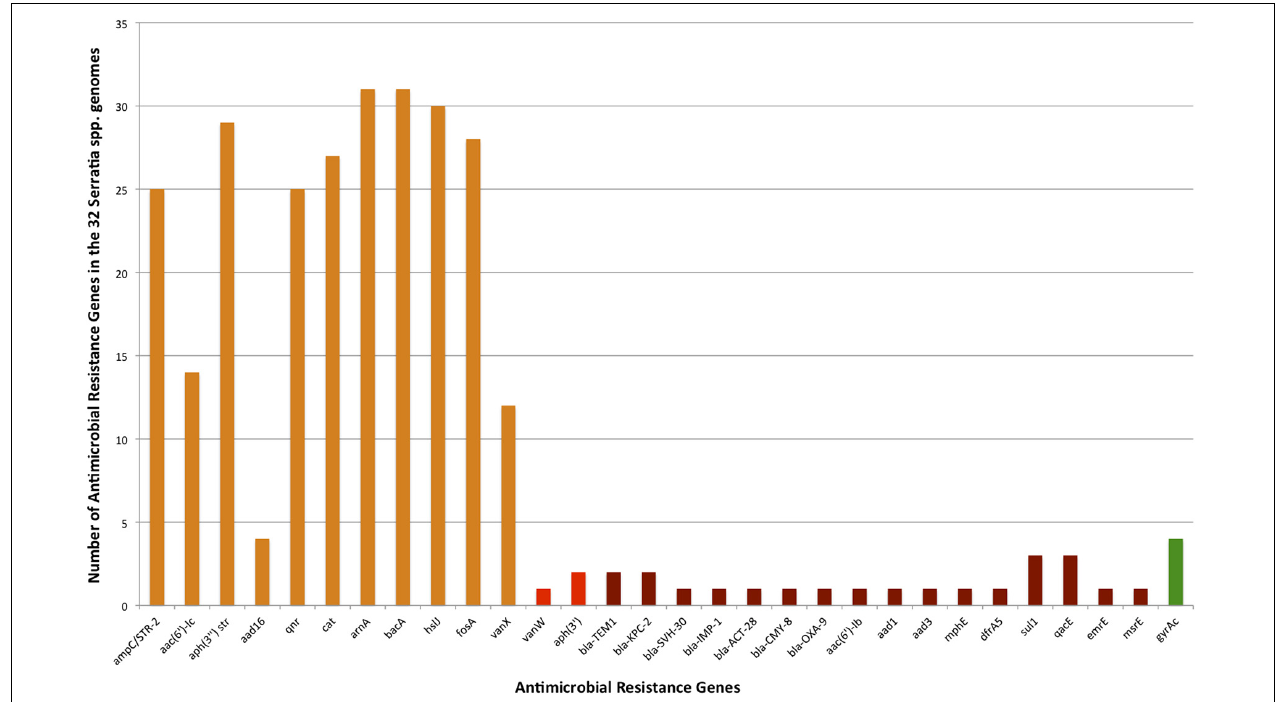
FIGURE 4 | Number of intrinsic and acquired ARGs identified in the 32 Serratia genomes (efflux pump genes not included). Intrinsic ARGs in orange color, acquired in red, and acquired by mutation in green.